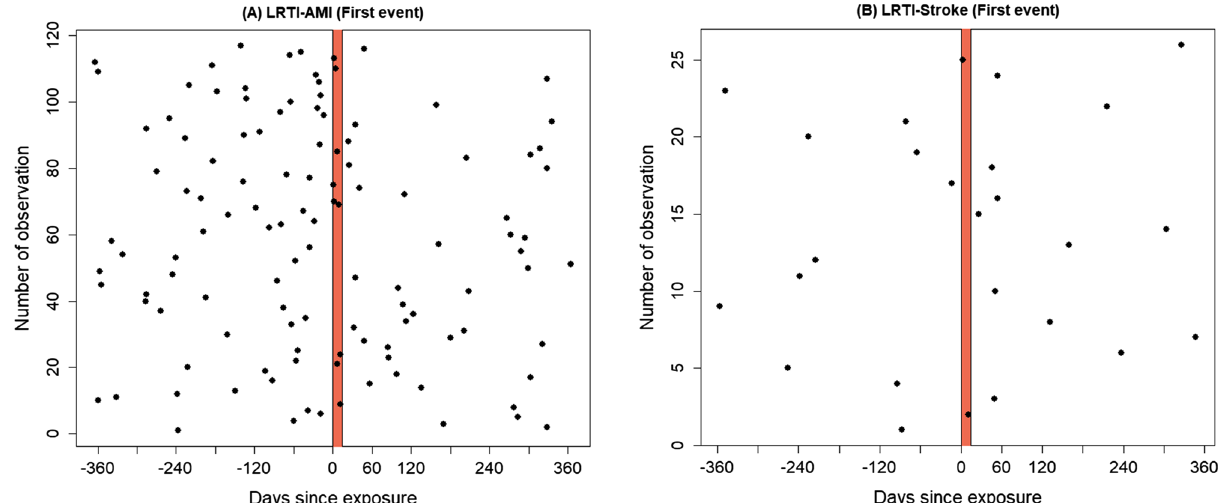
Figure 2. Plot of individual patient-level observation period and the 14 days LRTI risk periods (shaded). Days since exposure is the number of days before or after hospitalisation for